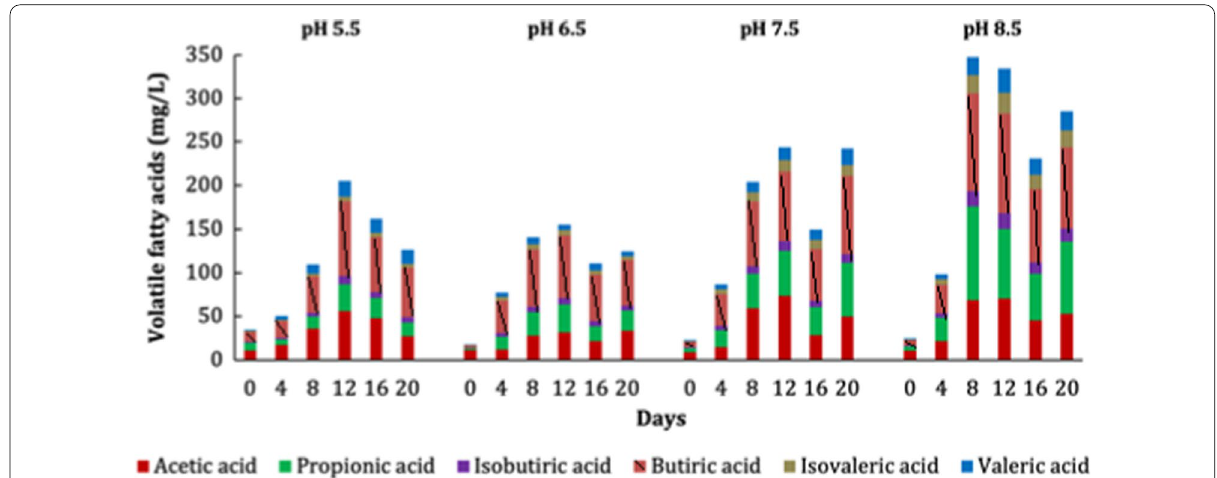
Fig. 2 Production of VFAs during the anaerobic digestion of cow manure at initial pH values of 5.5, 6.5, 7.5, and 8.5